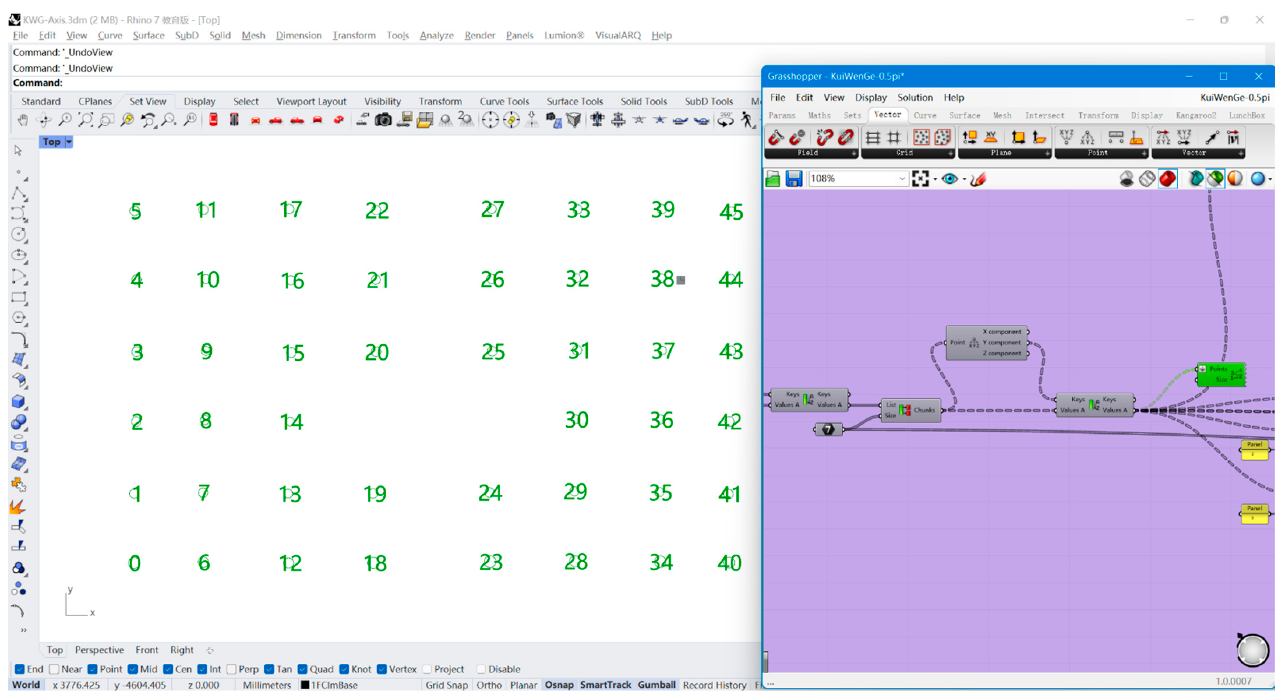
Figure 4. Sort centroids by coordinates.